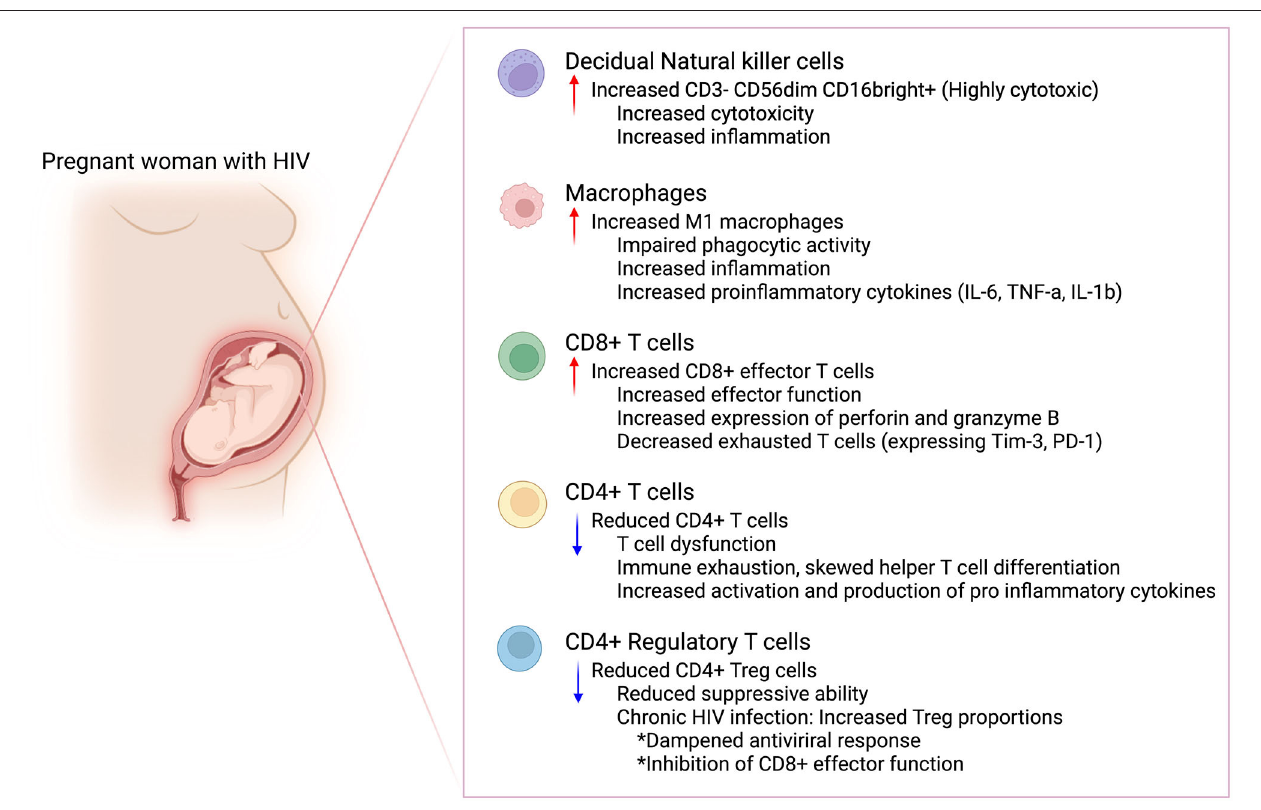
FIGURE 2 | Possible immune perturbances in the maternal decidua in women with HIV. Maternal HIV infection could lead to immune perturbances in the maternal decidua. This immune dysfunction could increase the risk for preterm birth in women with HIV. Created in